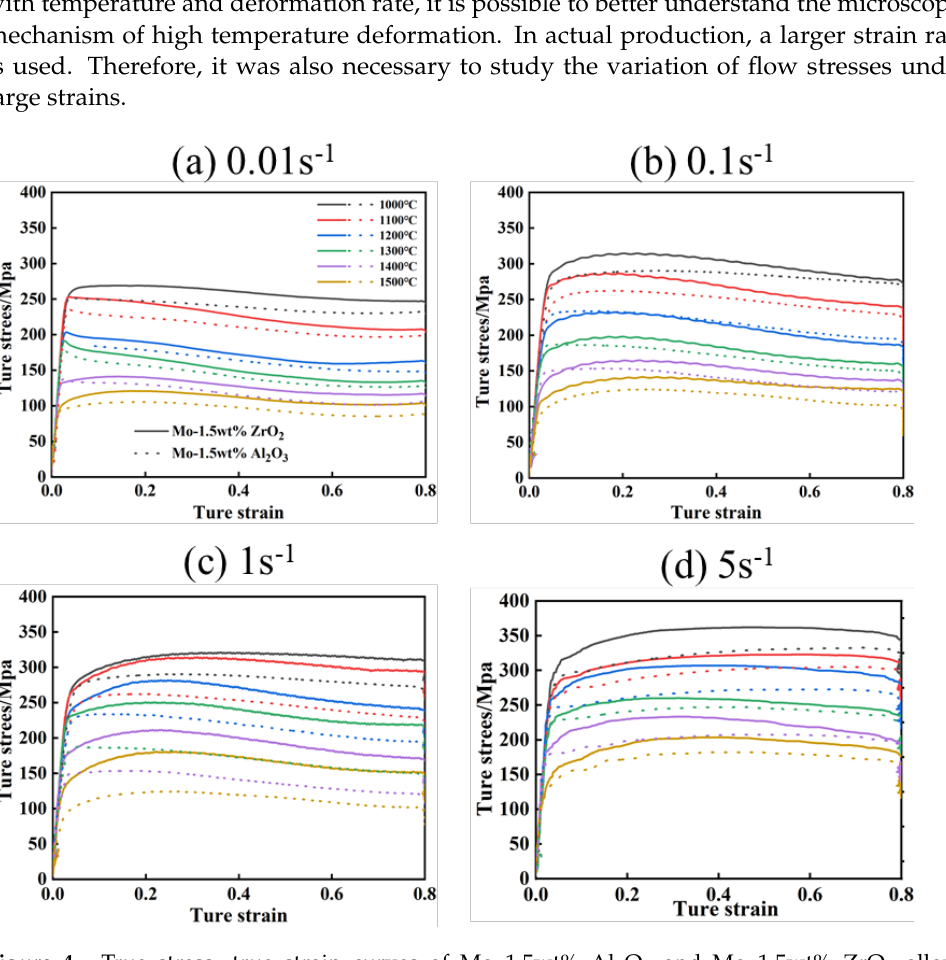
Figure 4. True stress − true strain curves of Mo − 1.5wt% Al 2 O 3 and Mo − 1.5wt% ZrO 2 alloys: ( a ) 0.01 s −1 , ( b ) 0.1 s −1 , ( c ) 1 s −1 , ( d ) 5 s −1.